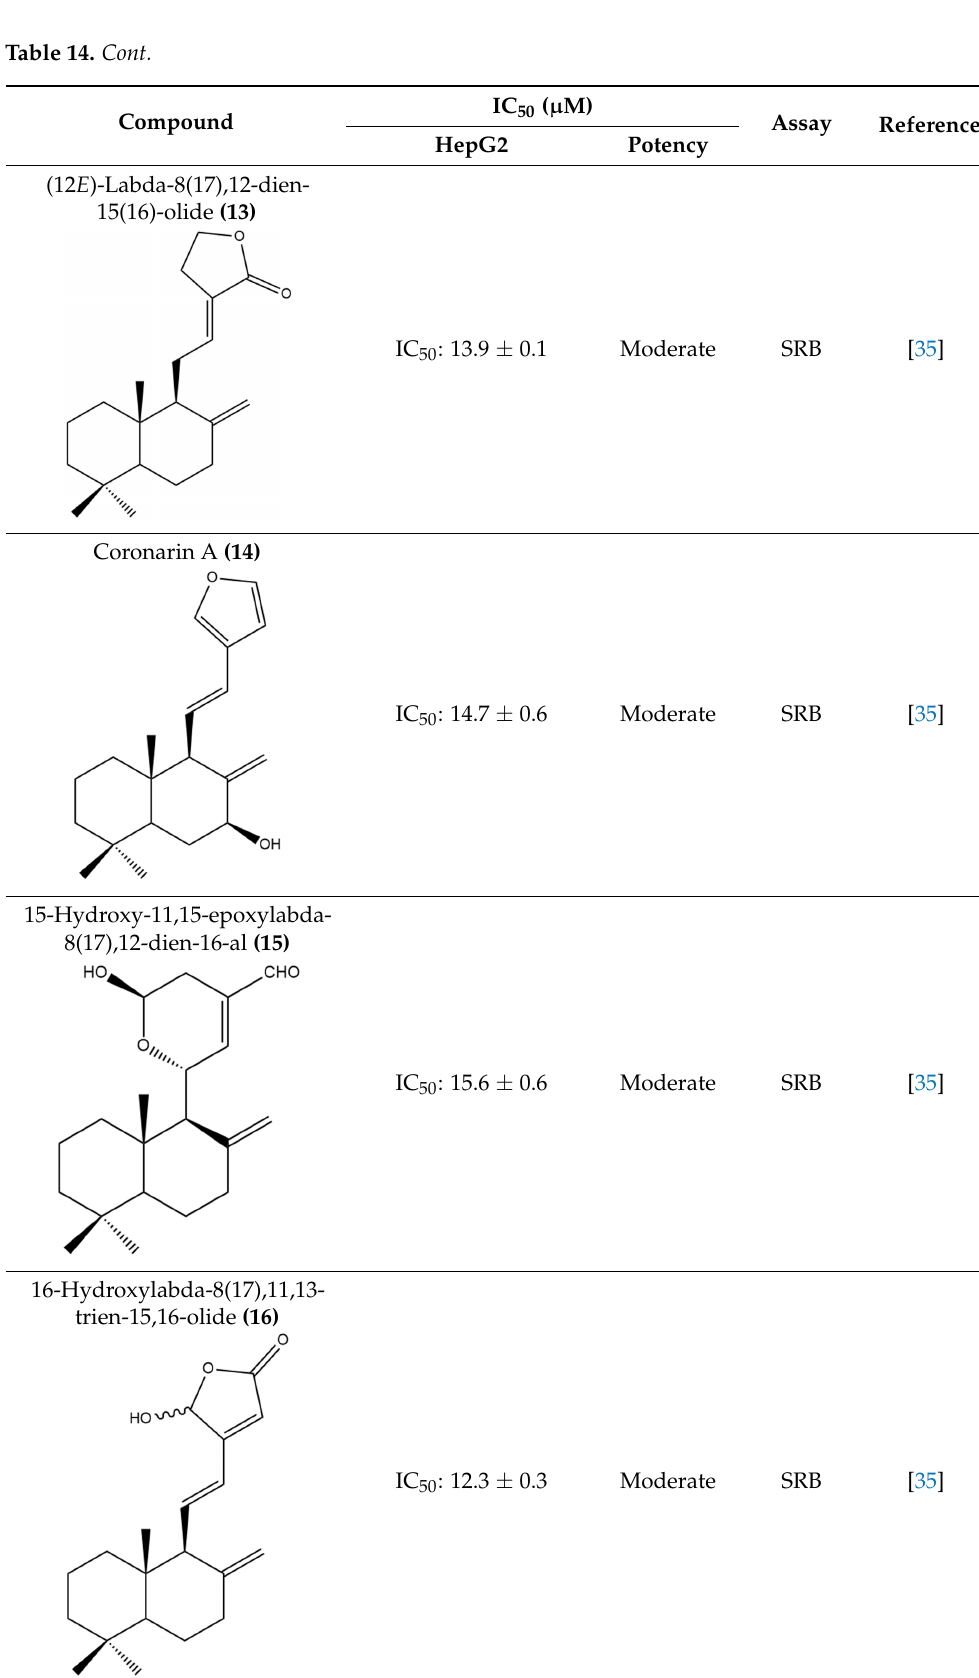
Table 15. Cytotoxic activities of labdane-type diterpenes from the Zingiberaceae against COLO 205 colorectal cancer cell line.